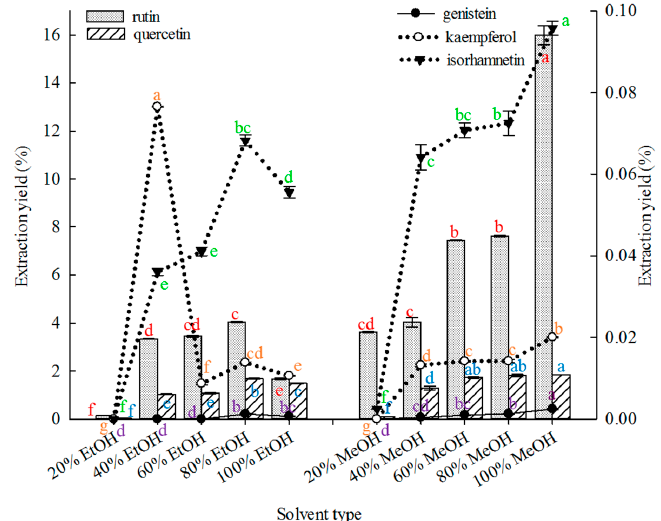
Figure 1. Effects of solvent type on the extraction yields of the five constituents (the bar and lines graphs as referenced to the left and right axes, respectively; different letters stand for significant difference at 5% level).